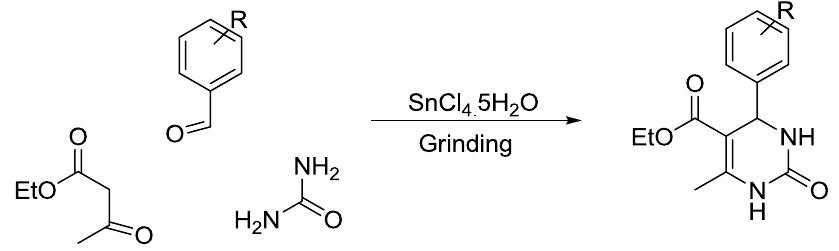
Scheme 35. Synthesis of dihydropyrimidones by Biginelli reaction.